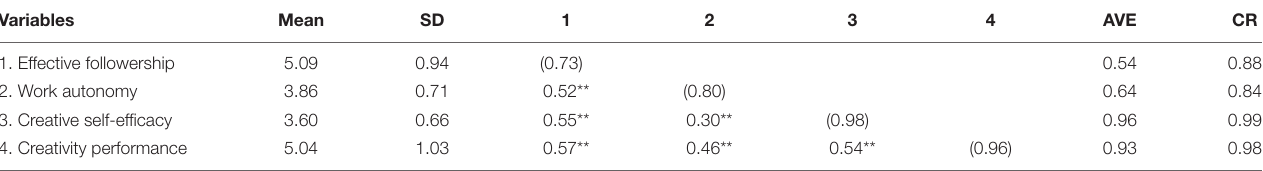
TABLE 1 | Means, standard deviations, correlations, average variance extracted, and composite reliability of the study variables. Variables